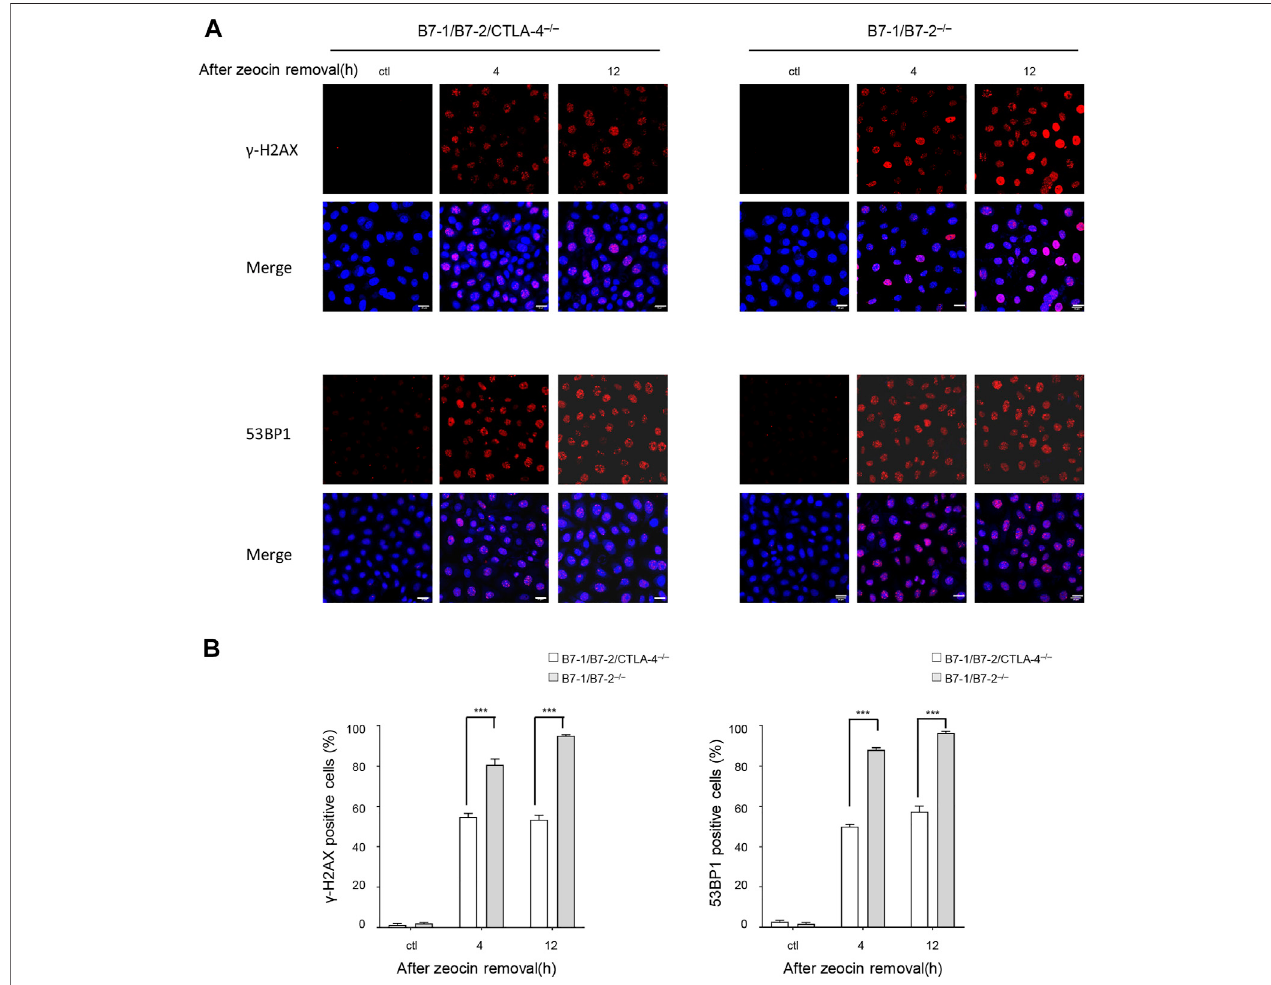
FIGURE3| Zeocintreatmentinducedmore γ H2AXfociand53BP1fociinCTLA-4 – expressingcells. γ H2AXand53BP1proteinaccumulationatDNAdamagesites forms cytologically discernible foci. (A) DNA damage was measured by determining the number of γ H2AX and 53BP1 foci using immuno fl uorescence detection. Representativeimagesarepresented.TheB7-1/B7-2 − / − andB7-1/B7-2/CTLA-4 − / − Tcellsweretreatedwithoutorwith500 μ g/mlzeocinfor1 hfollowedbycultureina normalmediumfortheindicatedtimesandthenstainedfor γ H2AX(red), 53BP1(red), andnuclei(DAPI,blue).Scalebar,20 μ m. (B) Quantitationofthedatashown in (A) . The histograms represent the percentage of cells with more than 10 γ H2AX and 53BP1 nuclear foci. Each experiment was independently performed three times ( n = 3), and more than 100 cells were counted in each experiment. The data are presented as the mean ±SEM; *** p < 0.001.